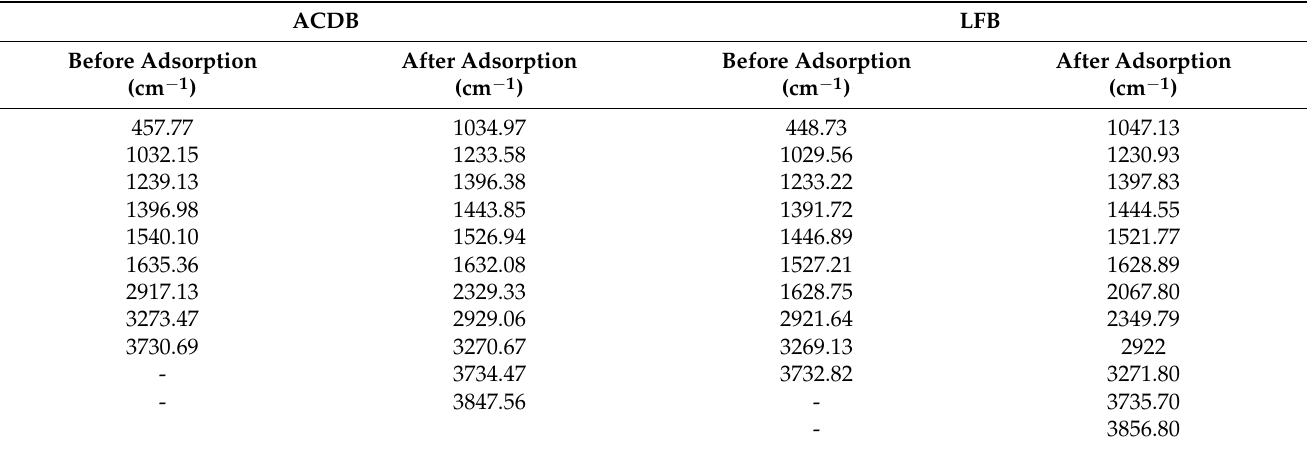
Table 2. FT-IR spectrum of the tested ACDB and LFB, before and after